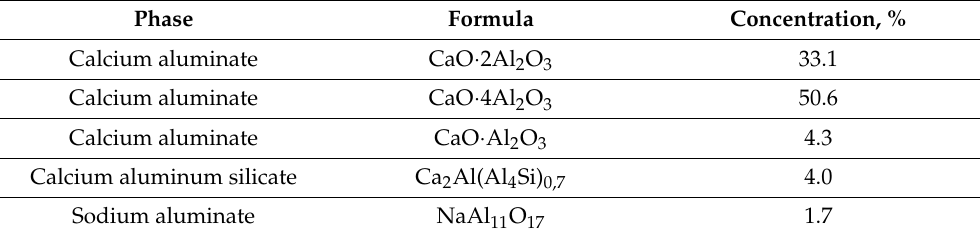
Table 12. Results of semi-quantitative analysis of